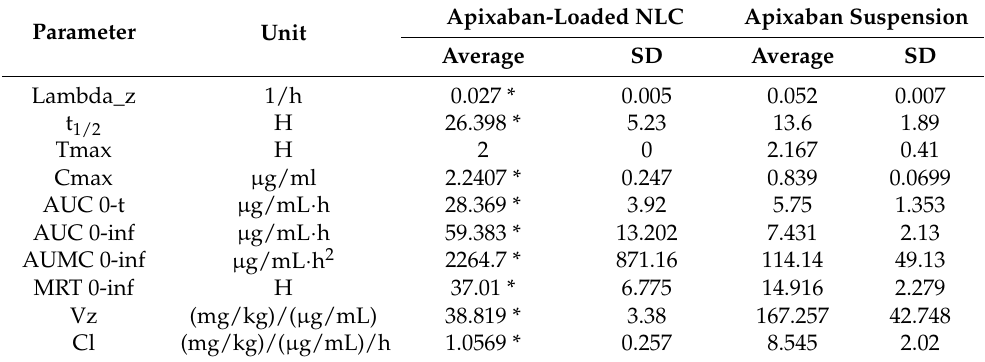
Figure 6. Statistical analysis of main pharmacokinetic parameters after oral administration of 60 mg/kg of both Apx- NLC and free Apx suspension (mean ± SD, n = 6). Note: *** and **** denote significant effects at p -values less than 0.001, and 0.0001, respectively.